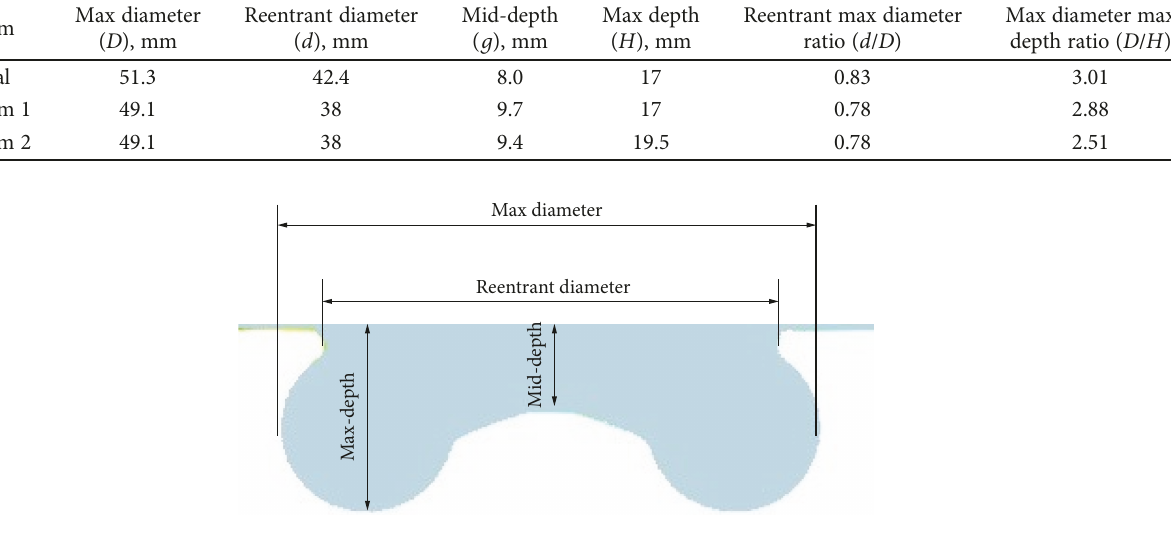
Figure 3: Geometry and size of the combustion chamber.